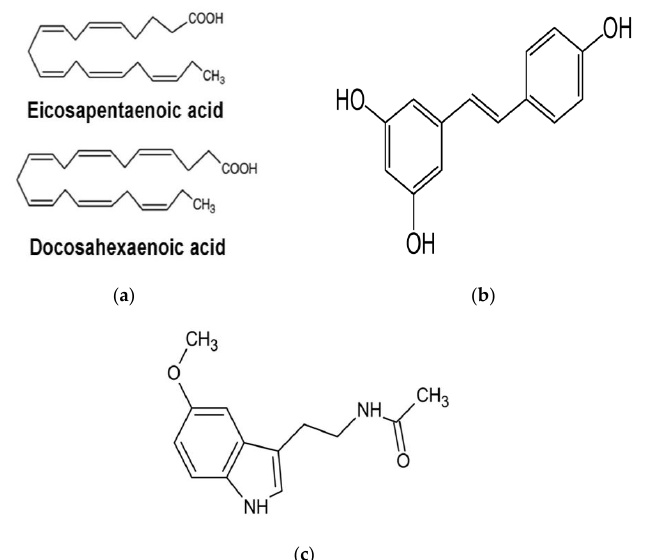
Figure 2. Proposed antioxidant regimen: ( a ) Long chain ω-3 polyunsaturated fatty acids; ( b ) Resveratrol; ( c ) Melatonin. Omega-3 (ω-3) polyunsaturated fatty acids. PUFAs comprise five substances: eicosapentaenoic acid (EPA), alpha-linolenic-acid, stearidonic acid, docosahexaenoic acid (DHA), and docosapentaenoic acid. Of particular relevance are long-chain ω-3 PUFAs such as EPA and DHA, which are abundant in the body lipids of fatty fish, the liver of white lean fish, and the blubber of marine mammals [123]. EPA and DHA are highly susceptible to free-radical oxidation [124], yet they have been shown to reduce urinary F2-isoprostane levels (a lipid peroxidation biomarker) and enhance the antioxidant systems of the cell [125]. Gao and colleagues published an in vitro study which showed that oxidised EPA and DHA react directly with Keap1, a negative regulator of Nrf2, inducing Nrf2-directed gene expression [125], thus acting as indirect antioxidants. The consumption of long chain ω-3 PUFAs has shown improvements in sperm SOD and CAT activities [126], sperm cell concentration [126], sperm motility [127] and DNA fragmentation [128]. These compounds have been safely used in doses of up to 1.8 g/day in a RCT [126]. Resveratrol. Resveratrol is a phenolic compound derived from stilbene naturally found in foods such as grapes, nuts, cranberries and red wine [129]. It possesses several beneficial effects on human health that are derived from its antioxidant and anti- inflammatory properties [130]. The antioxidant properties that resveratrol exhibits are partly due to being an excellent scavenger of . OH, O 2- and metal-induced ROS, thereby protecting cell membranes from lipid peroxidation and DNA from ROS-mediated damage [131]. Moreover, this compound has been shown to act through the transcription factor named nuclear factor erythroid 2–related factor 2 (Nrf2) pathway, as it downregulates Keap1 [132], a protein involved in the ubiquitination and proteasomal degradation of Nrf2